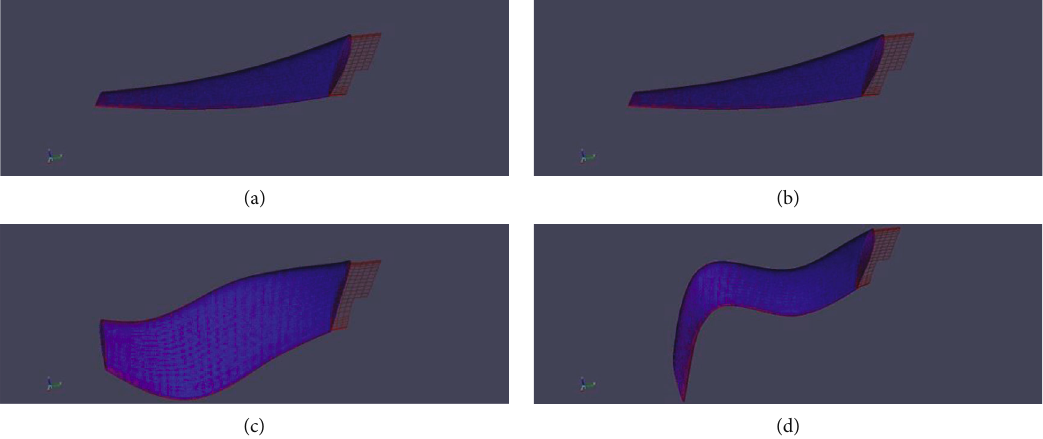
Figure 11: The interpolation of the vibration shapes based on IIM method: (a) the fi rst-order interpolation; (b) the second-order interpolation; (c) the third-order interpolation; (d) the fourth-order